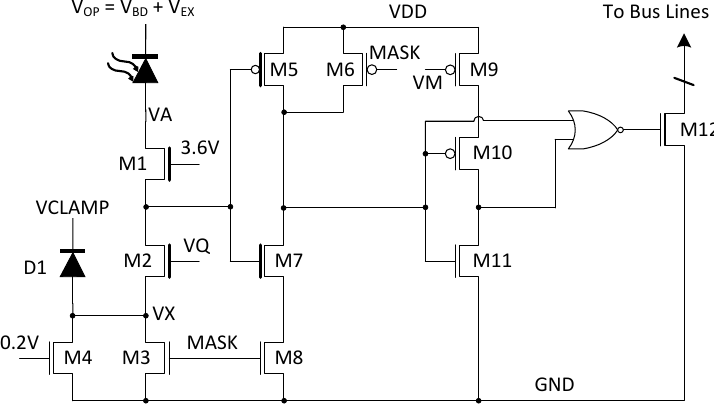
Figure 2. Pixel schematic with cascaded quenching.